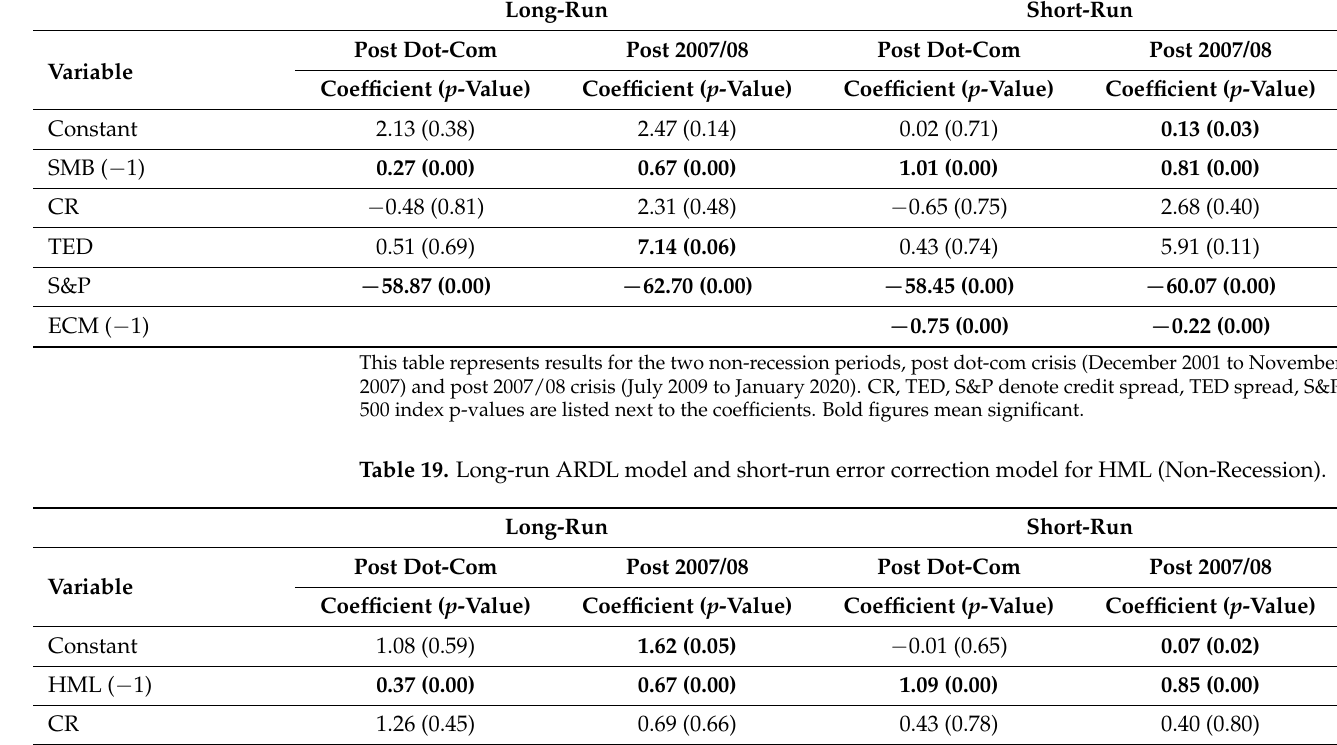
Table 18. Long-run ARDL model and short-run error correction model for SMB (Non-Recession). Long-Run Short-Run